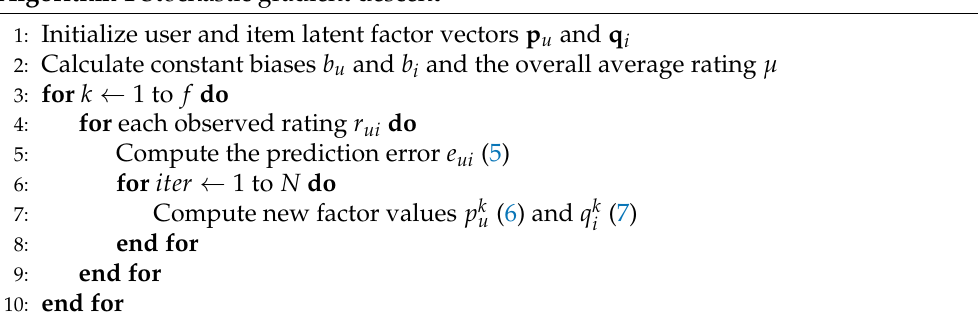
Algorithm 1 Stochastic gradient